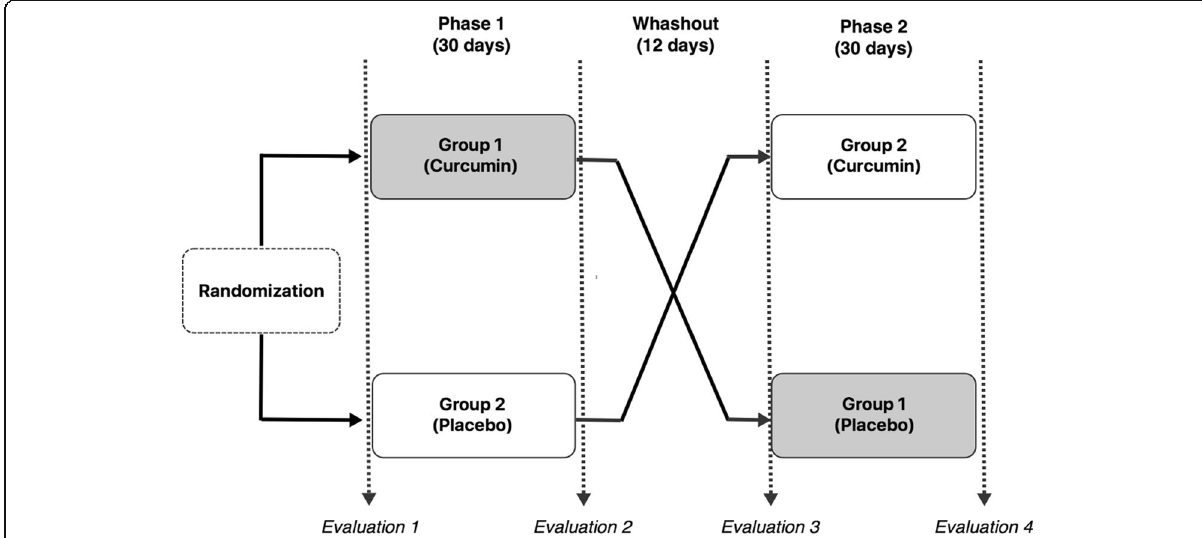
Fig. 1 Study Design. Legend: This figure shows the formulation of the trial, including the randomization process, phase 1, washout, and phase 2 periods. Also, it shows the groups 1 and 2 as experimental group (EG) and control group (CG), respectively, and their cross-over during the follow up. In addition, four reference points for evaluations 1 – 4 are pointed out. Each evaluation was comprised by full assessment, including anamnesis, 24-h dietary recall, indirect calorimetry, dual-energy X-ray absorptiometry, blood collection, and biochemical